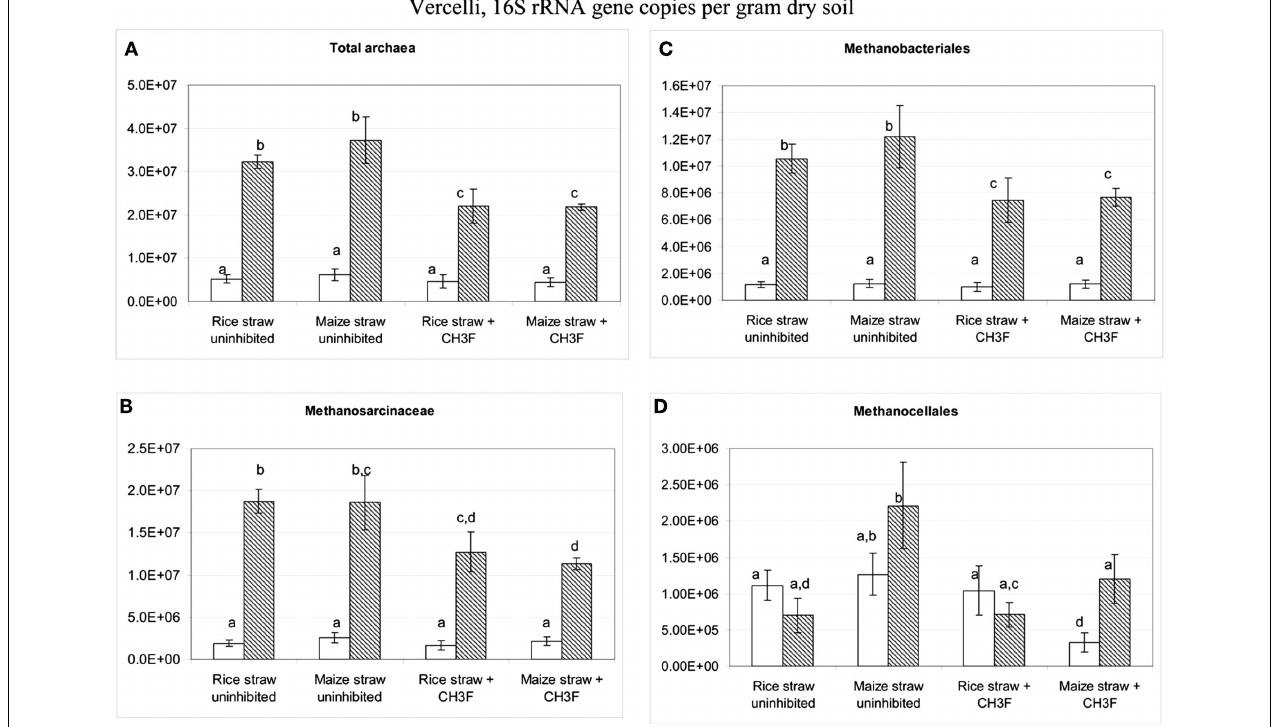
Vercelli soil with either rice straw or maize straw in the presence and absence of CH 3 F; mean ± SE, n = 3. Different letters indicate significant ( p < 0.05) differences between columns. Beginning and end of incubation are as in Figure 1